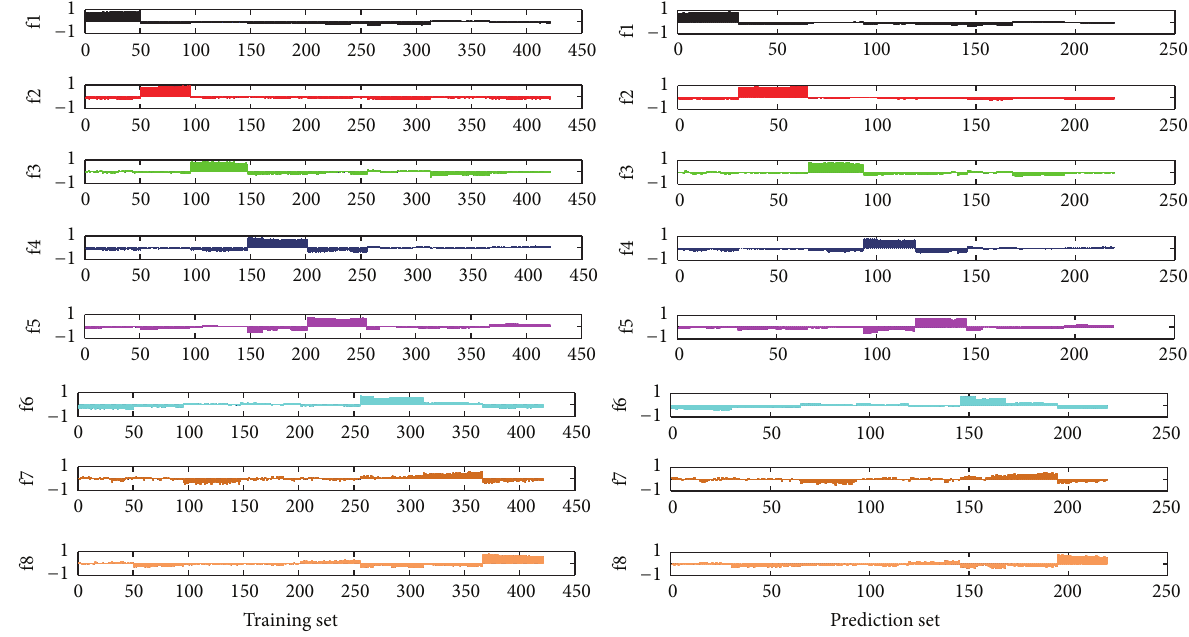
Figure 6: Assigned plots of dummy codes of the training set and prediction set for the raw NIR spectra in PLSDA